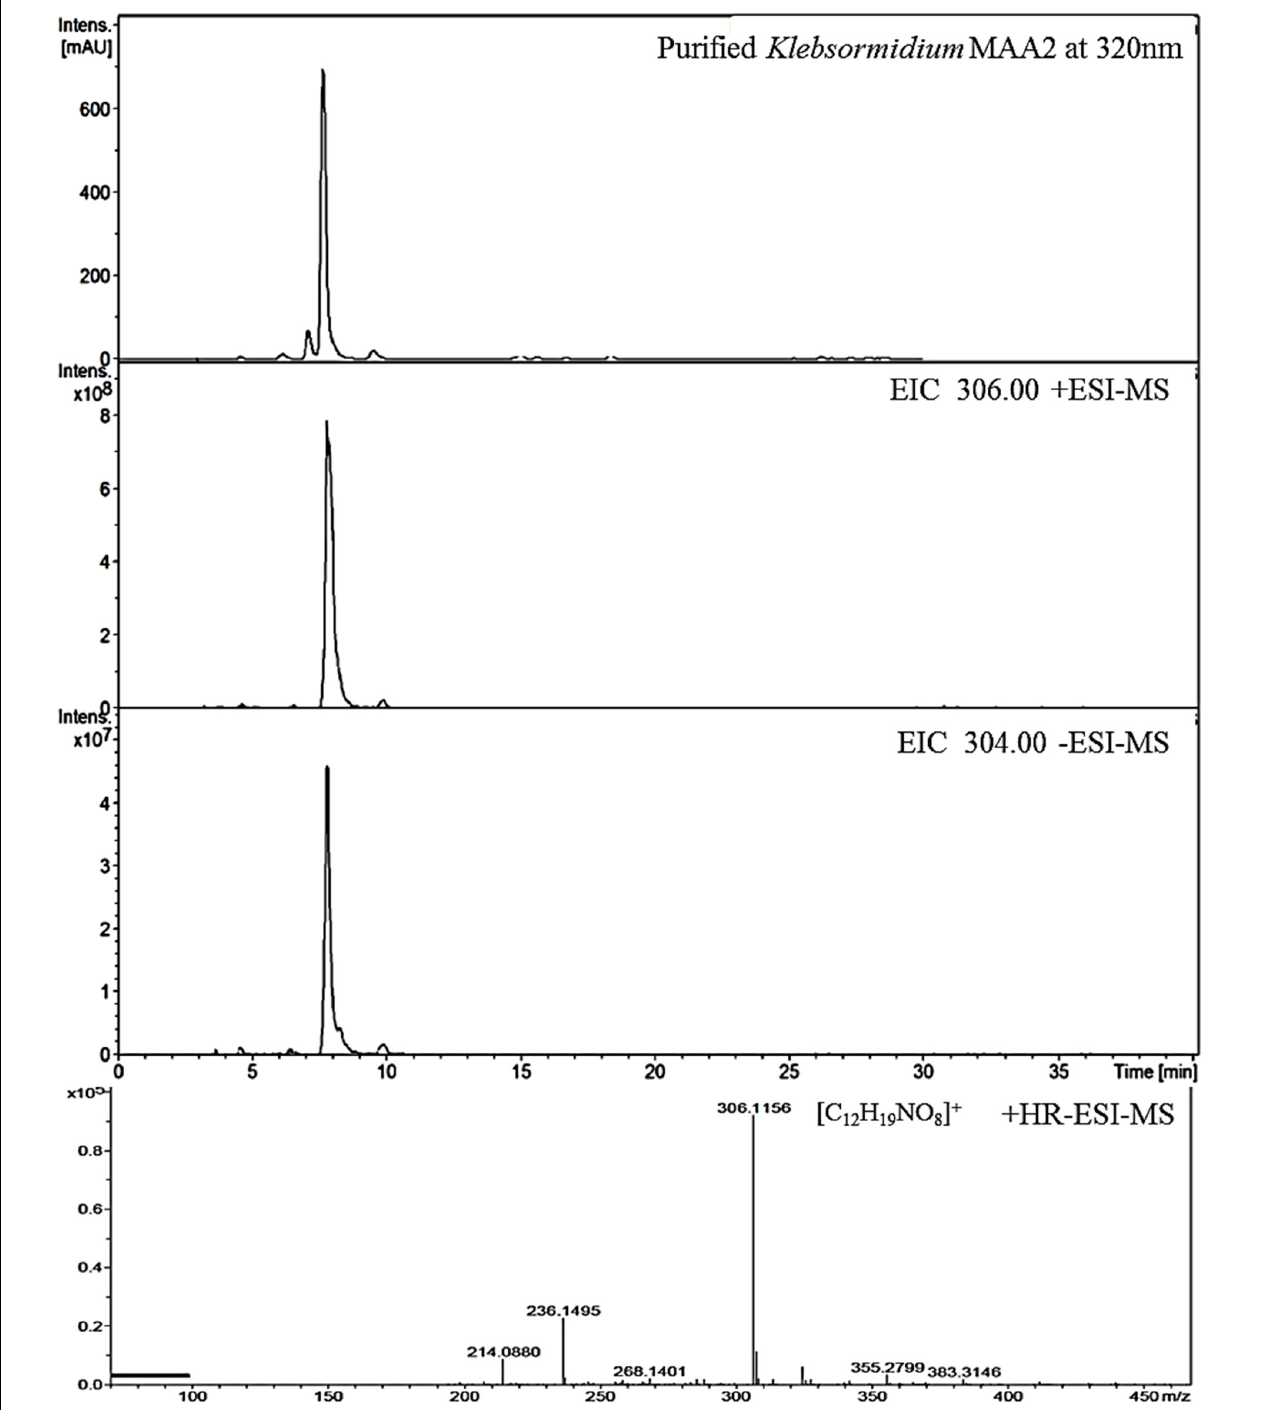
FIGURE 3 | High resolution – electrospray ionization – mass spectrometry (HR-ESI-MS) spectra recorded for Compound 2 (klebsormidin B) isolated from extracts of Klebsormidium crenulatum .